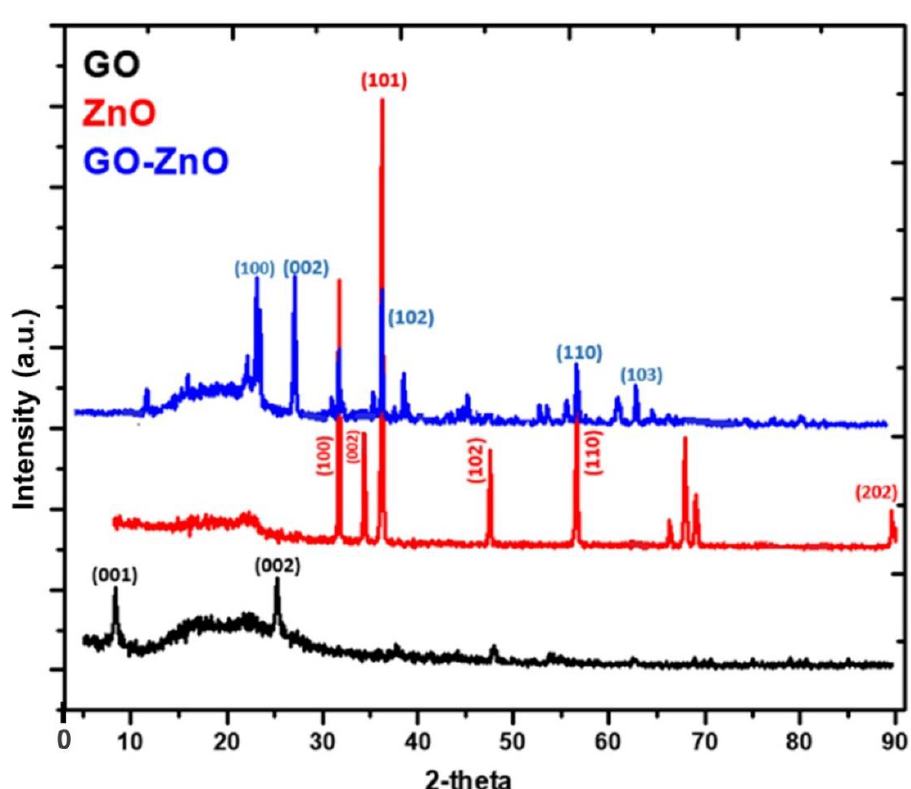
Figure 4. XRD diffractogram of as-prepared GO, ZnO and GO-ZnO nanocomposite.